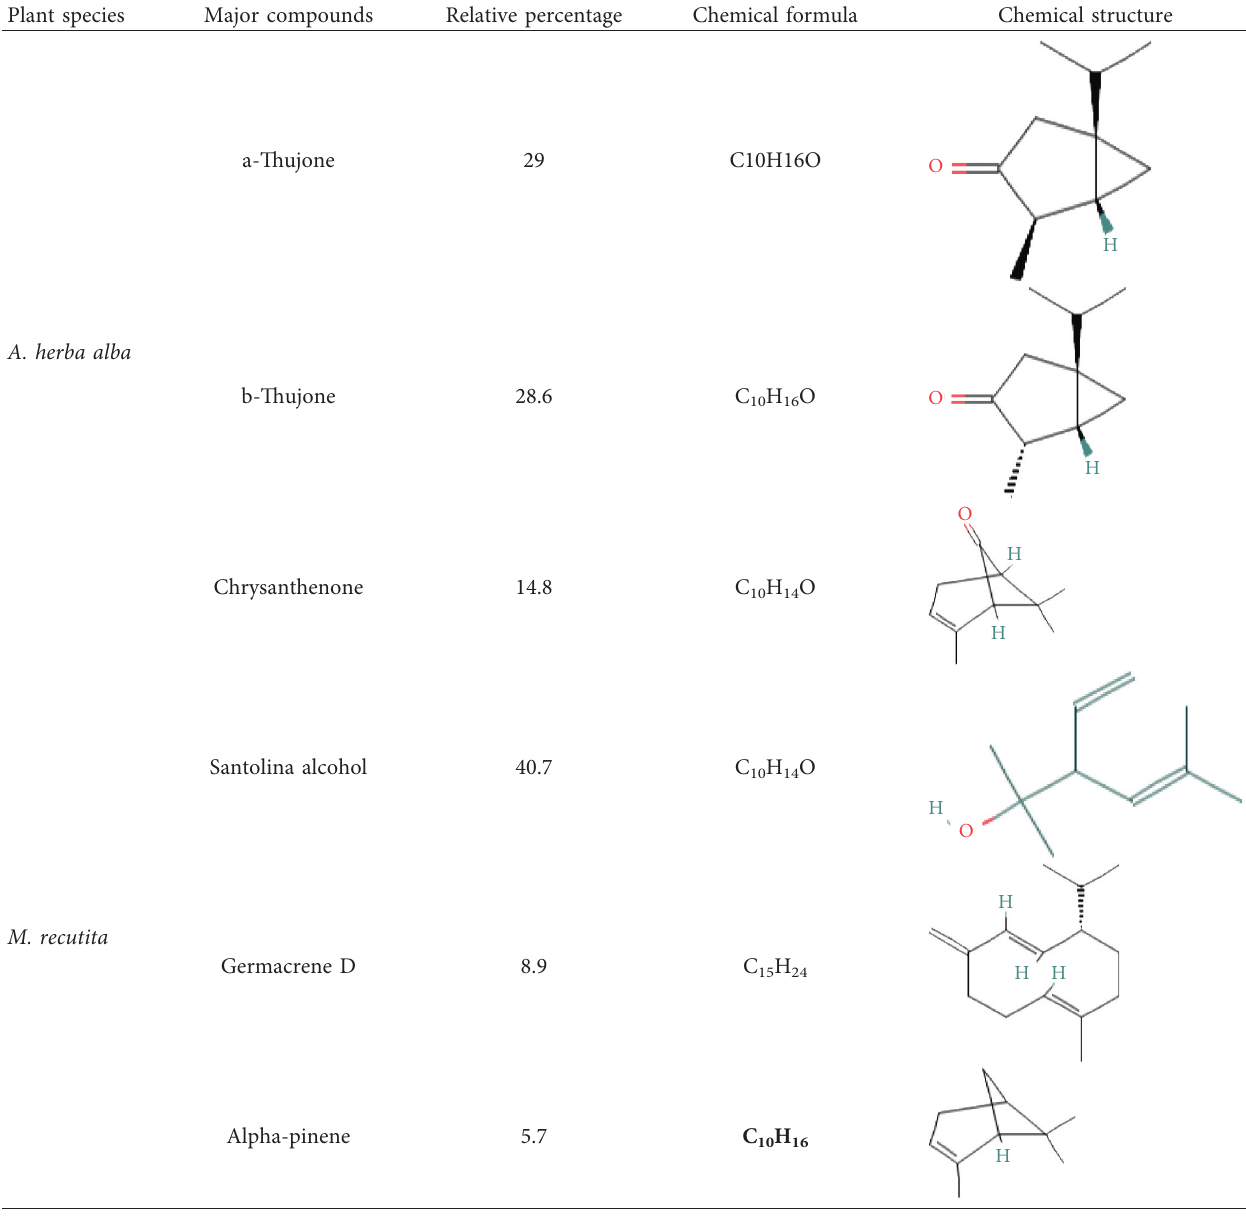
Table 3: Major compounds of essential oils of Artemisia herba alba Asso., Matricaria recutita L., and Dittrichia viscosa L. Plant